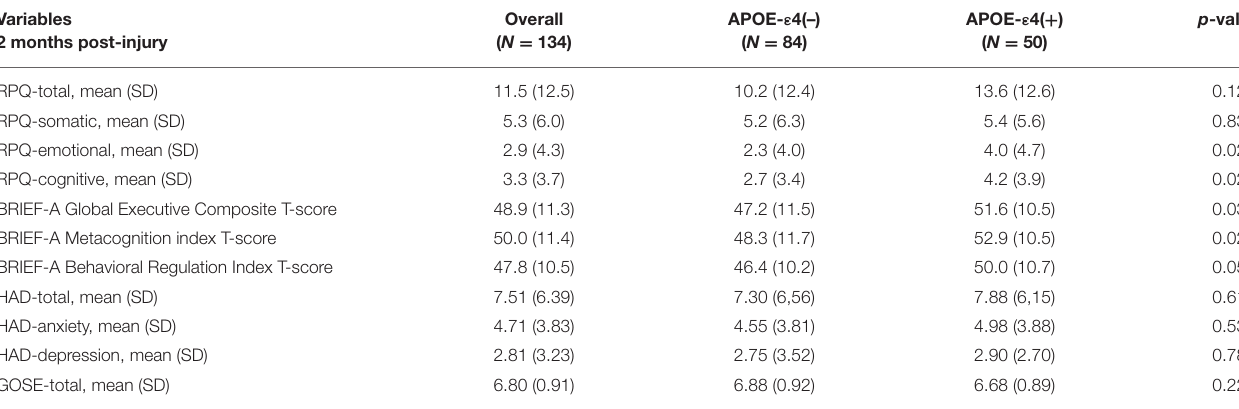
TABLE 3 | Self-reported outcome measures according to APOE- ε 4 status